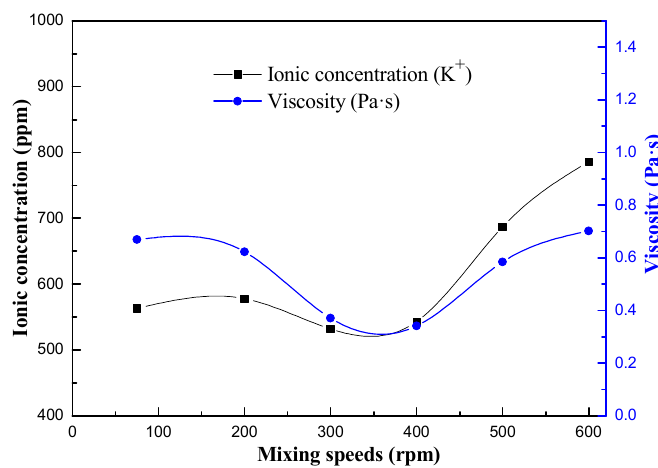
Figure 10. Relationship between ionic concentration (K + ) and viscosity of CPB-D.